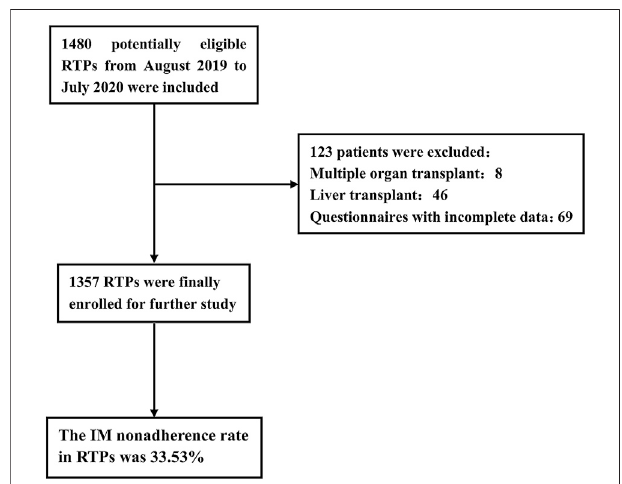
FIGURE 1 | The study fl